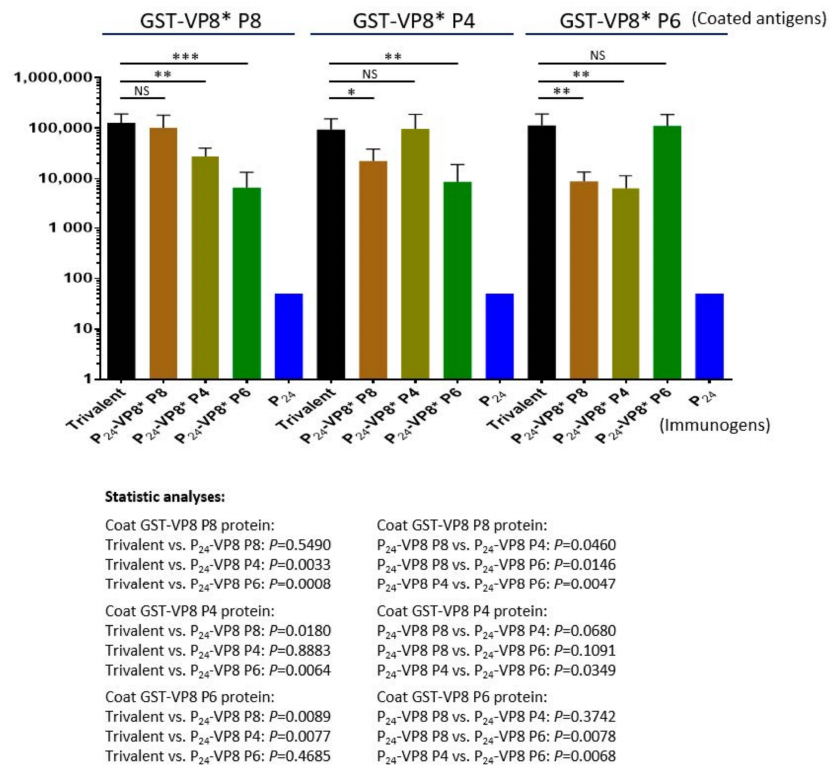
Figure 5. Antibody responses in mice of the trivalent P 24 -VP8* nanoparticle vaccine to the three homologous VP8* types compared with those of the three individual P 24 -VP8* nanoparticles. The Y- axis shows the VP8*-specific IgG titers, while the X-axis indicates different immunogens. Statistical differences between data groups with corresponding P -values are calculated and indicated below the figure. “ns”, non-significant for p -values > 0.05, *, significant for p -values < 0.05, **, highly significant for p -values < 0.01, ***, extremely significant for p -values < 0.001.